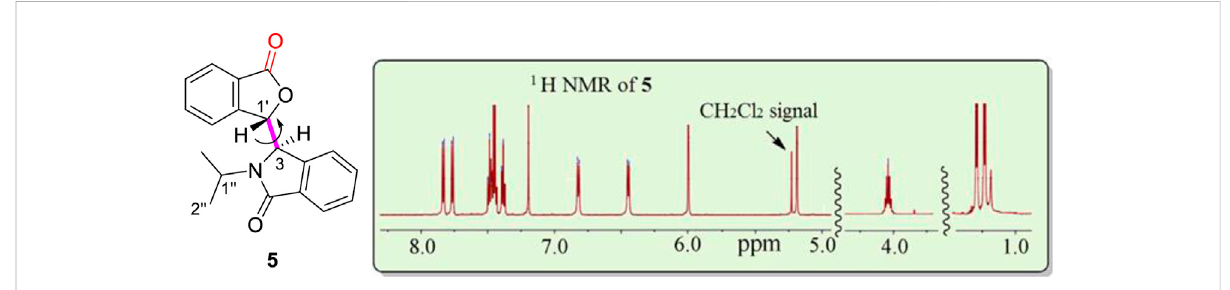
FIGURE 4 One 1 H NMR spectrum at room temperature for racemic 5 (signal-free regions of the spectrum are hidden for clarity). There are a total of eight aromatic proton signals from 6.4 to 7.9 ppm, two isolated protons (H3, 5.19 ppm, H1 ′ , 6.00 ppm), two methyl groups (H2 ″ , 1.1 ppm) and one proton (H1 ″ , 4.0 ppm), respectively. Residual CH 2 Cl 2 remained from the isolation of 5 and was recorded at 5.25 ppm in the 1 H NMR spectrum.